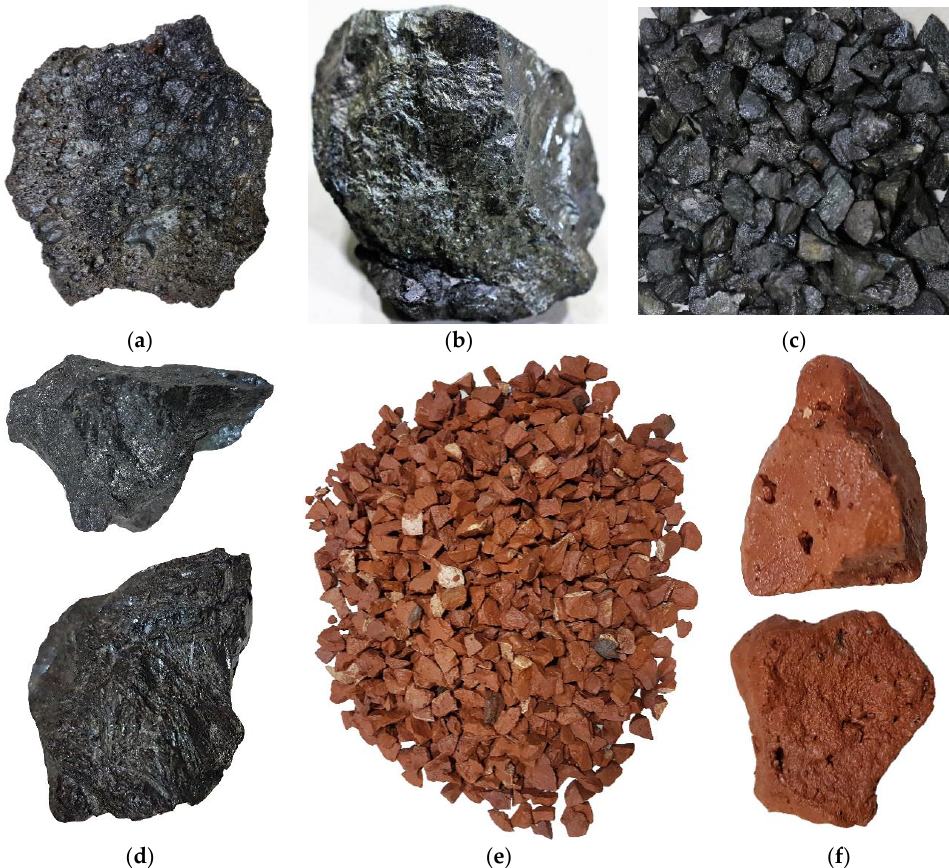
Figure 1. Induction furnace steel slag boulders: ( a ) steel slag with more void, ( b ) steel slag with less void; steel slag aggregate (SSA): ( c ) steel slag coarse aggregate, ( d ) close view of SSA; brick aggregate (BA): ( e ) brick coarse aggregate, ( f ) close view of BA.